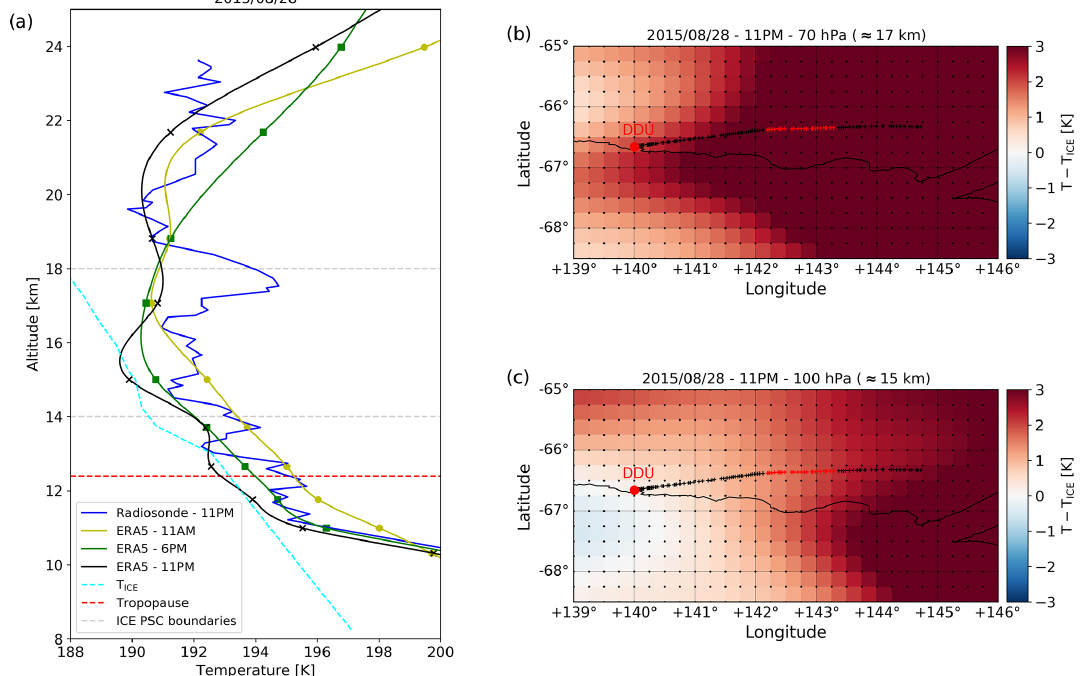
Figure 7. (a) 28 August 2015 DDU temperature profiles from a local radiosonde launched at 23:00UTC (blue line), ERA5 reanalyses at 12:00UTC (green line), at 18:00UTC (yellow line) and at 23:00UTC (black line). T ICE threshold temperature is indicated by the sky blue dashed line; the red dashed line shows the dynamic tropopause from ERA5. The boundaries of the ICE PSC detected at DDU from approximately 15:00 to 20:00UTC are shown by grey dashed lines. (b, c) Temperature fields from ERA5 reanalyses on 28 August 2015 at 23:00UTC respectively at 70hPa, approx. 17km, and 100hPa, approx. 15km. The trajectory of the radiosonde launched at DDU on 28 August 2015 at 23:00UTC is shown by black and red dots. Red dots correspond to heights between 14 and 18km i.e. the boundaries of the ICE PSC detected at